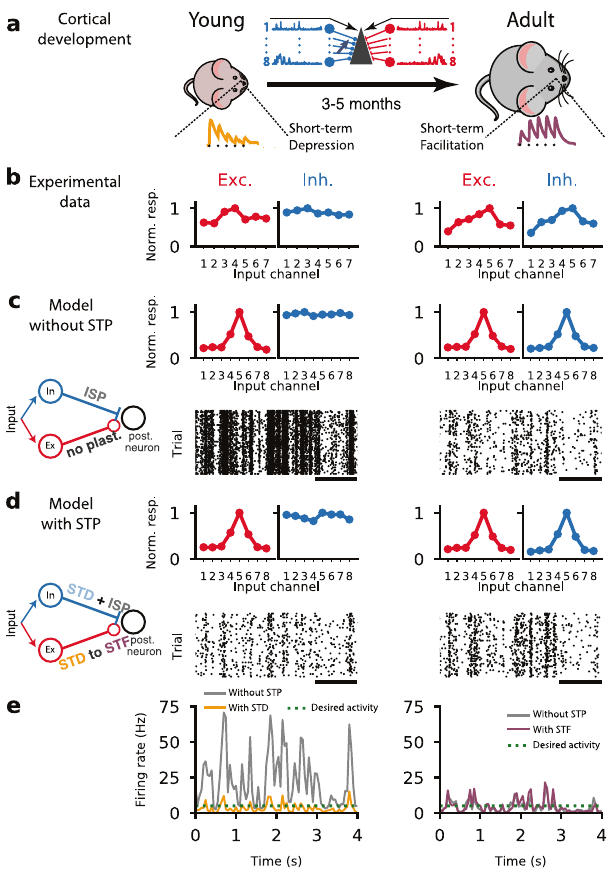
Fig. 1 A feedfoward cortical circuit with short-term synaptic plasticity exhibits low fi ring rates in both young and adult conditions. a Schematic of animal development from young with short-term depression (left) to adult with short-term facilitation (right) at excitatory synapses as observed experimentally 8 – 10,13,14 . Traces of short-term synaptic plasticity (STP) for depression (orange) and facilitation (purple) 8 . In the middle is a schematic of the feedforward neural circuit with eight independent input channels, each with an excitatory (red) and an inhibitory (blue) group synapsing onto a postsynaptic neuron (Fig. S2). b Inhibitory tuning does not mirror excitatory tuning in young animals (left). Once animals reach adulthood, a precise excitation-inhibition (EI) balance can be observed. Panels adapted from a previous study 26 . c Computational model with long-term synaptic plasticity in inhibitory synapses (ISP; see inset) started from unbalanced excitation-inhibition (top left) and gradually developed EI balance (top right). Neuron with unbalanced excitation-inhibition showed high activity (~20 Hz; bottom left), which was gradually reduced through ISP (~4.5 Hz; bottom right). Bottom raster plots represents postsynaptic spiking activity; black line corresponds to 1 second. d A computational model with both ISP and STP started from unbalanced excitation-inhibition (top left) and gradually developed EI balance (top right). Neuron with unbalanced excitation-inhibition shows low fi ring activity (~4.5 Hz; bottom left) throughout development (~4.5 Hz; bottom right). Bottom raster plots represents postsynaptic spiking activity; black line corresponds to 1 second. e Firing rates of a model without STP (left and right panels, solid gray line) and a model with both ISP and STP in young (left, solid orange line) and adult (right, solid purple line) conditions. Desired activity (dashed green line) represents baseline fi ring rate as observed experimentally 28 – 31